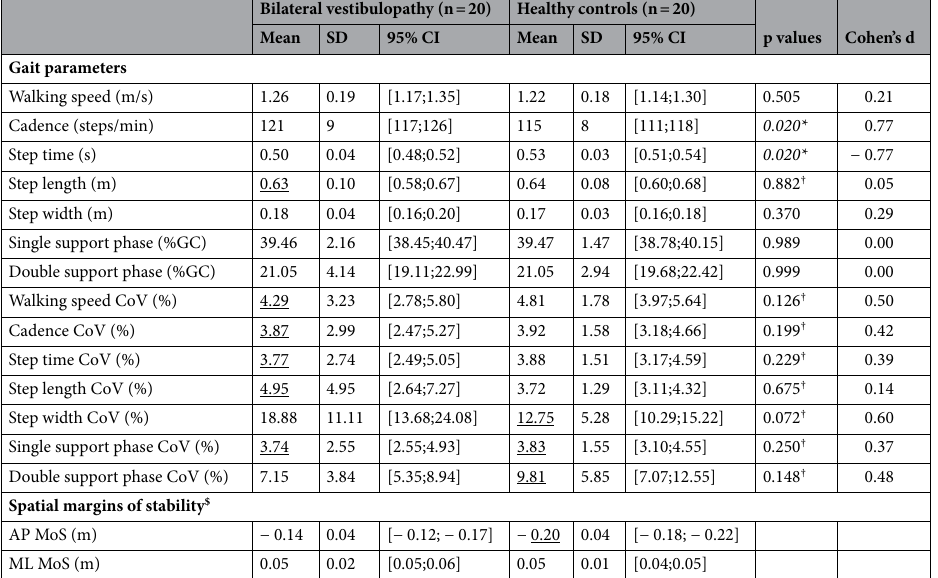
Table 2. Means and standard deviations of the spatiotemporal gait parameters, their variability (coefficient of variation), and spatial margins of stability in the bilateral vestibulopathy patients and healthy controls. m/s = metres per second; steps/min s steps per minute; s = seconds; m = metre; %GC = percentage of gait cycle; CoV = Coefficient of Variation; AP MoS = Anterior–posterior Margin of Stability; ML MoS = medio-lateral Margin of Stability. Underlined values represent non-normally distributed parameters. † Compared using the Mann–Whitney’s U test. *Significant at the 0.05. $ MoS are not compared.